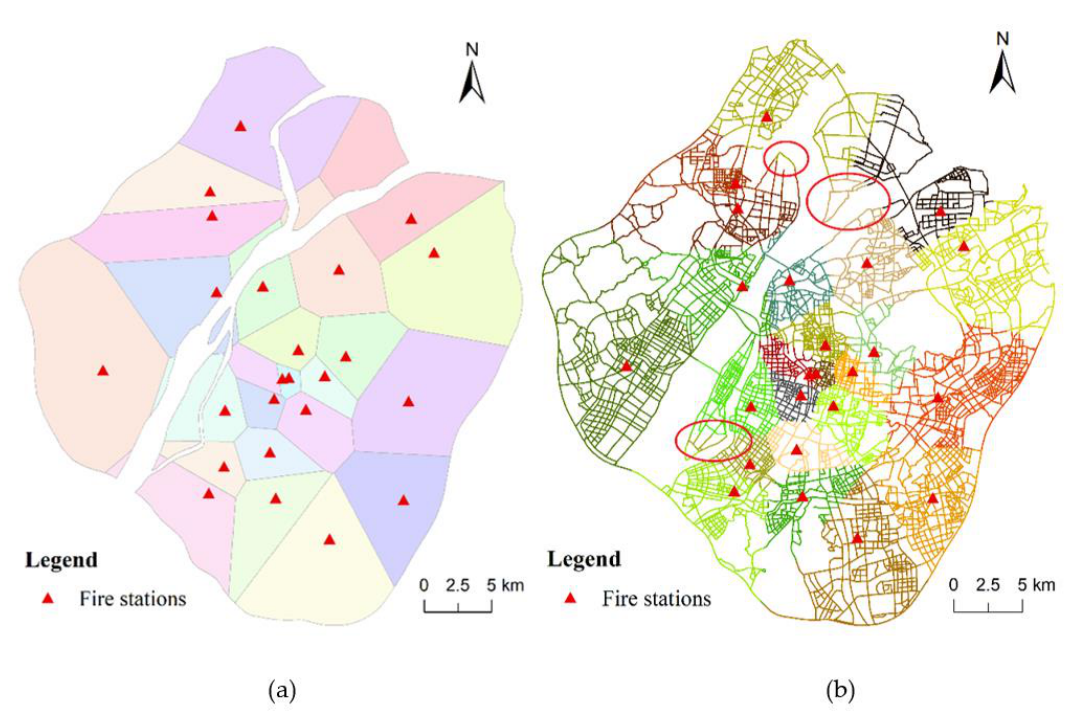
Figure 11. The service area division generated by the traditional planar Voronoi diagram: ( a ) the two-dimensional Voronoi structure and ( b ) the street segments that fall into each two-dimensional service area. Int. J. Environ. Res. Public Health 2020 , 17 , x